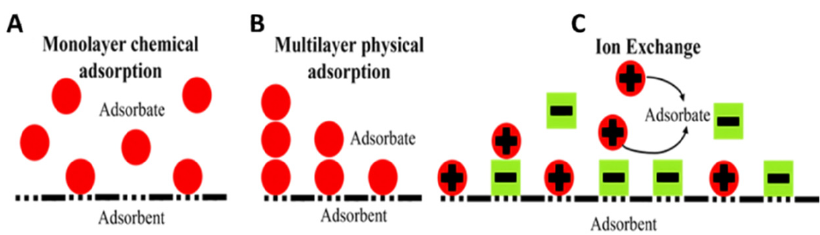
Figure 1. Adsorption mechanisms: ( A ) chemisorption monolayer; ( B ) physisorption multilayer; and ( C ) ion exchange adsorption.